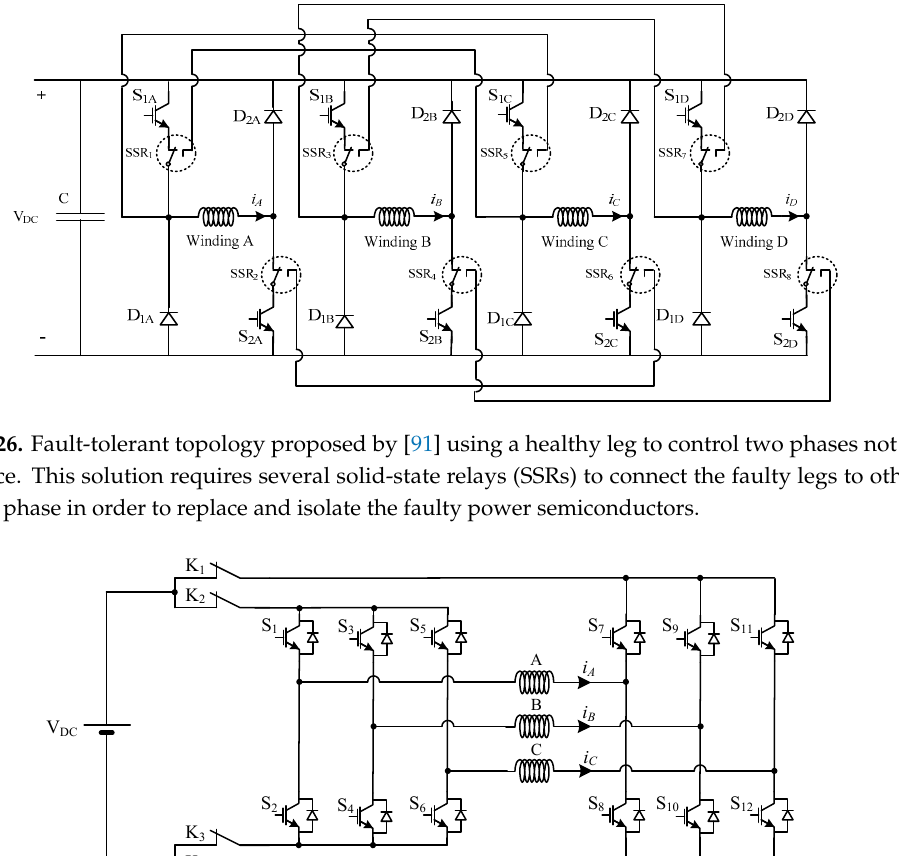
Figure 26. Fault-tolerant topology proposed by [91] using a healthy leg to control two phases not in sequence. This solution requires several solid-state relays (SSRs) to connect the faulty legs to other healthy phase in order to replace and isolate the faulty power semiconductors.